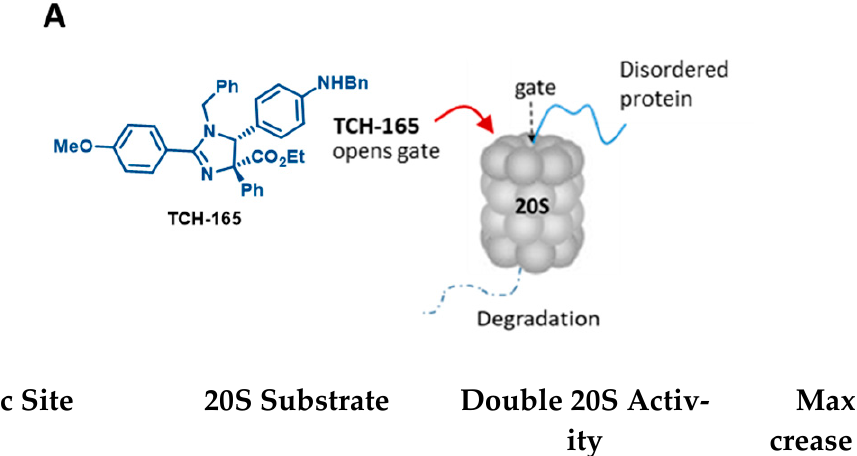
Figure 1. ( A ) Structure of TCH-165 and its proposed model of α -ring binding, allowing the gate to open for easy access of disordered proteins to the internal proteolytic sites; ( B ) EC 200 values of TCH- 165 and maximum fold enhancement of 20S activities for each of the three catalytic sites.